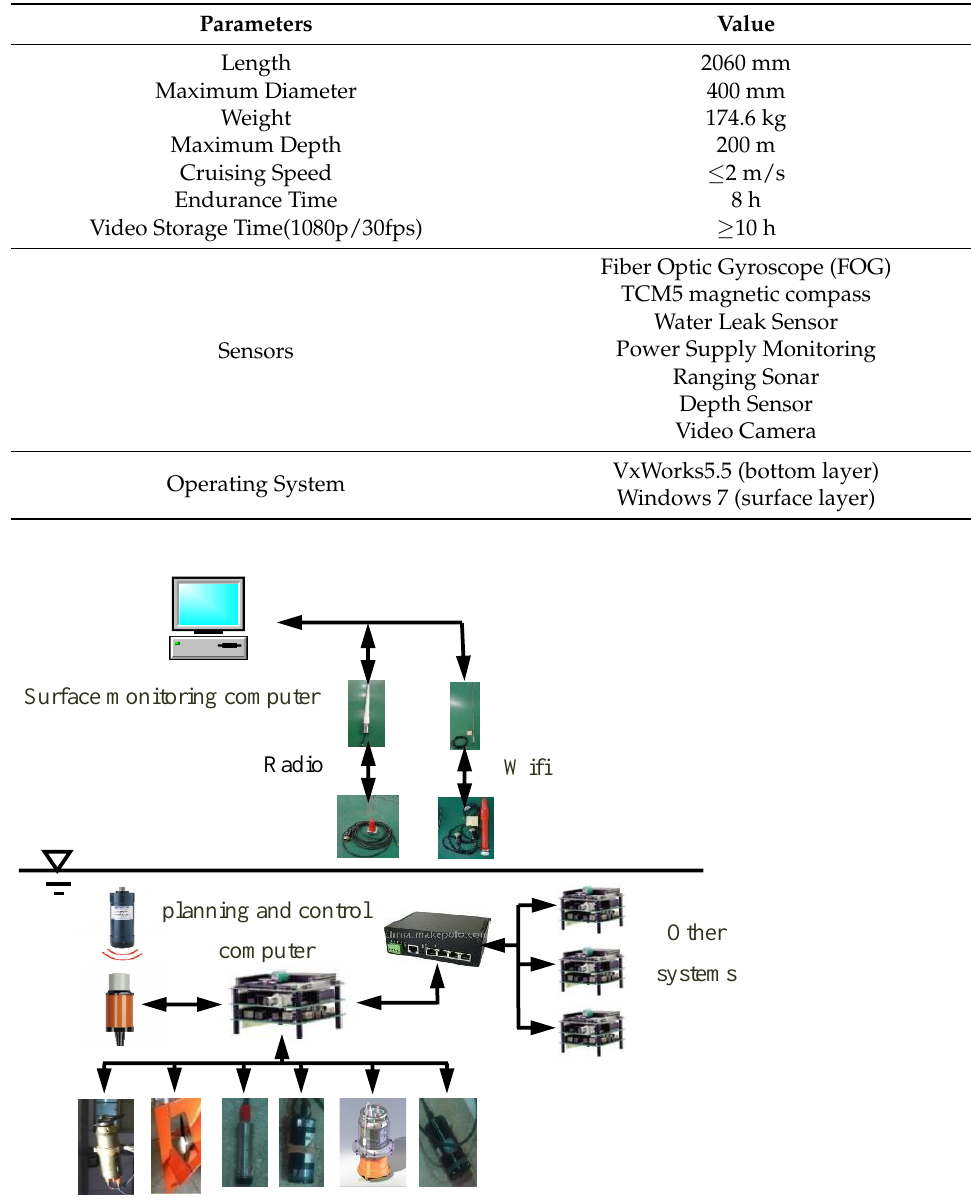
Figure 10. The system hardware architecture of the AUV.